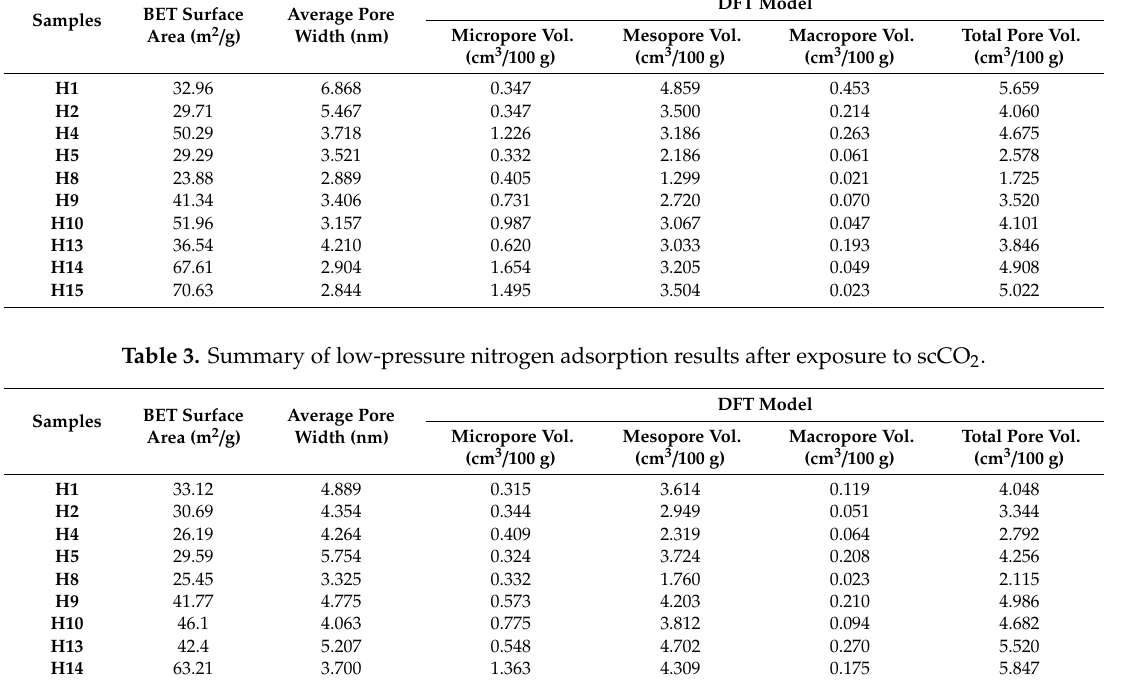
Table 2. Summary of low-pressure nitrogen adsorption results before exposure to scCO 2 . Samples